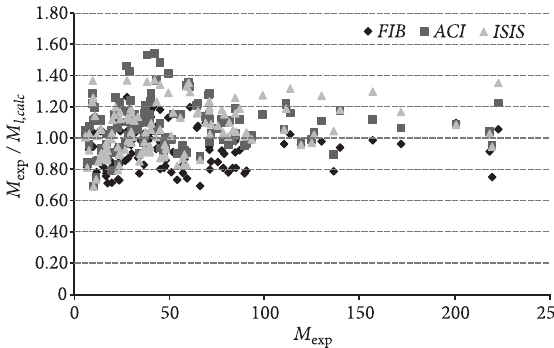
Fig. 3. Results of experimental and calculated ultimate moments